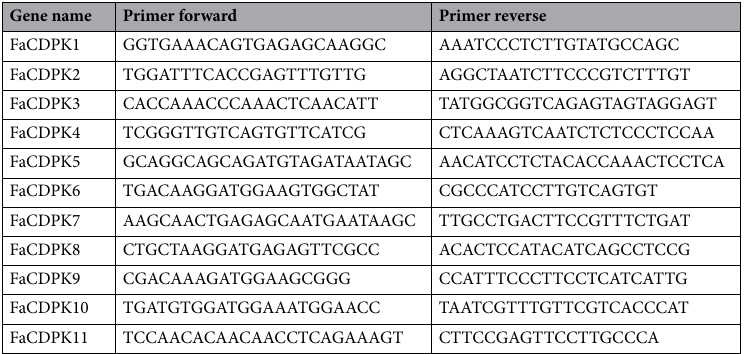
Table 2. Sequence of primers generated from the selected sequences of strawberry ( Fragaria x ananassa )